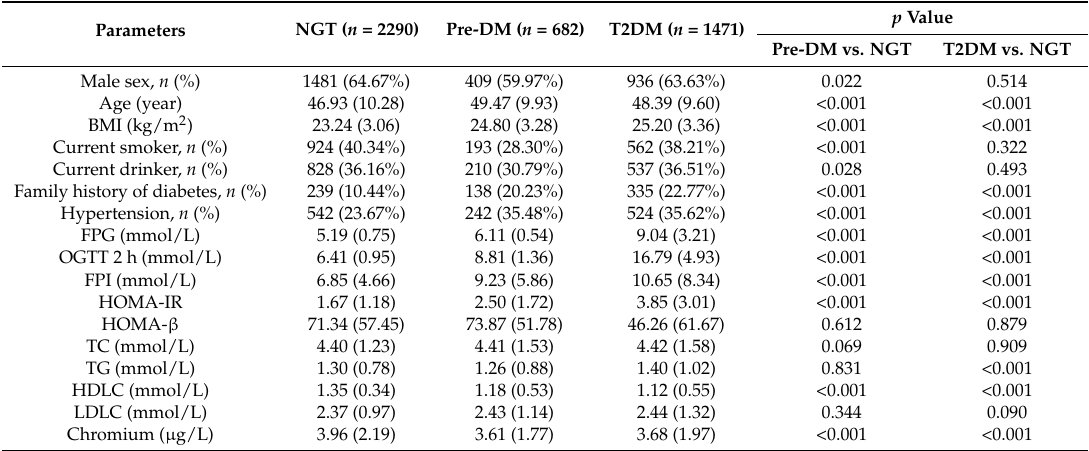
Table 1. Anthropometric and metabolic characteristics of NGT, pre-DM and T2DM groups. Parameters NGT ( n =